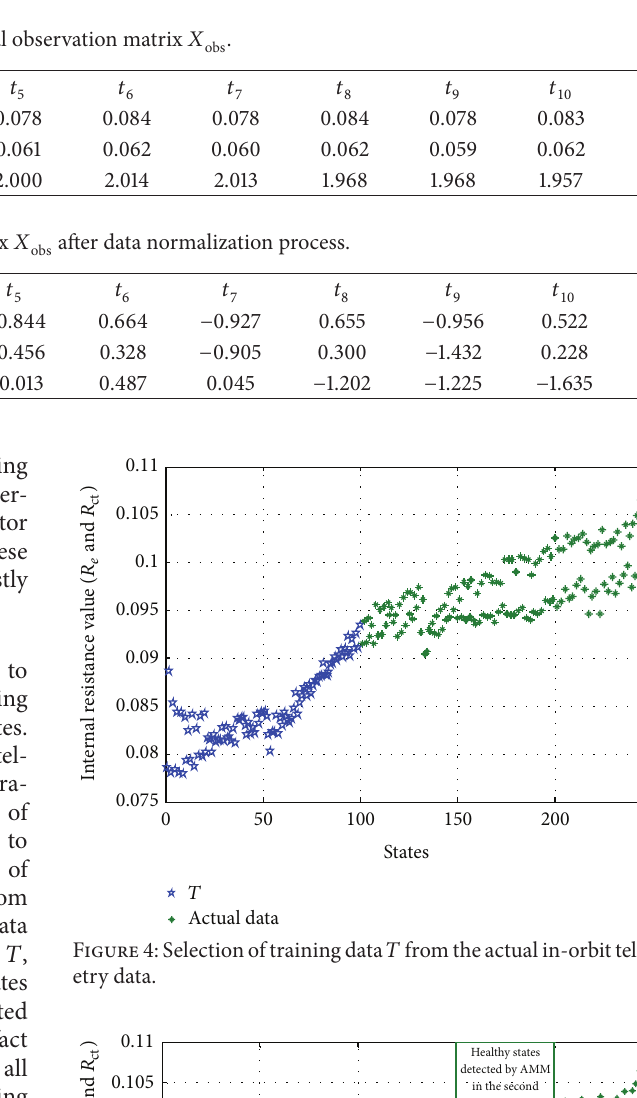
Table 1: Actual observation matrix 𝑋